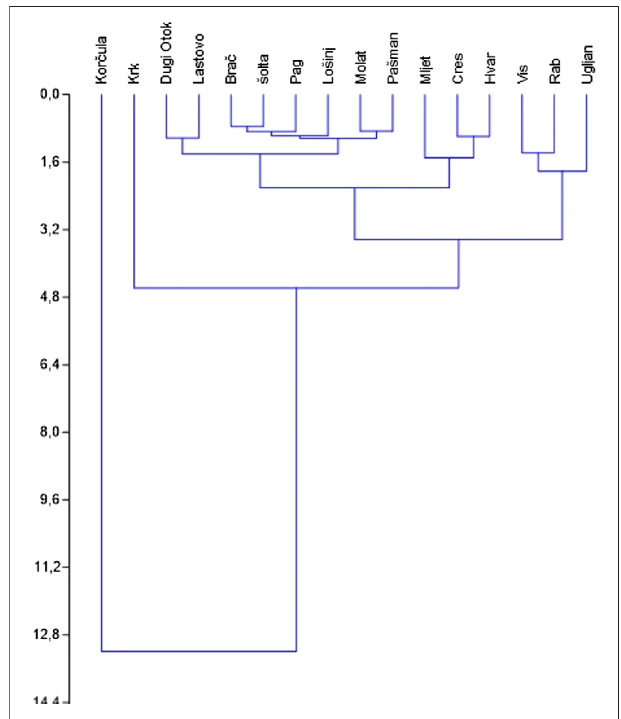
FIGURE 3 | Dendrogram showing UPGMA clustering (with Euclidean distance) of islands (those where over 10 interviews were carried